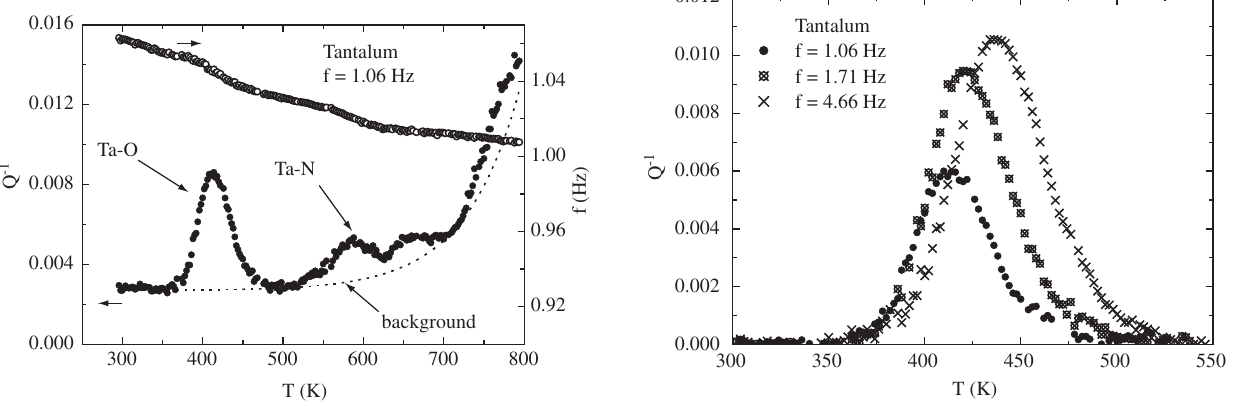
Figure 2. Anelastic relaxation spectrum of Ta measured with frequency of 1.06 Hz.